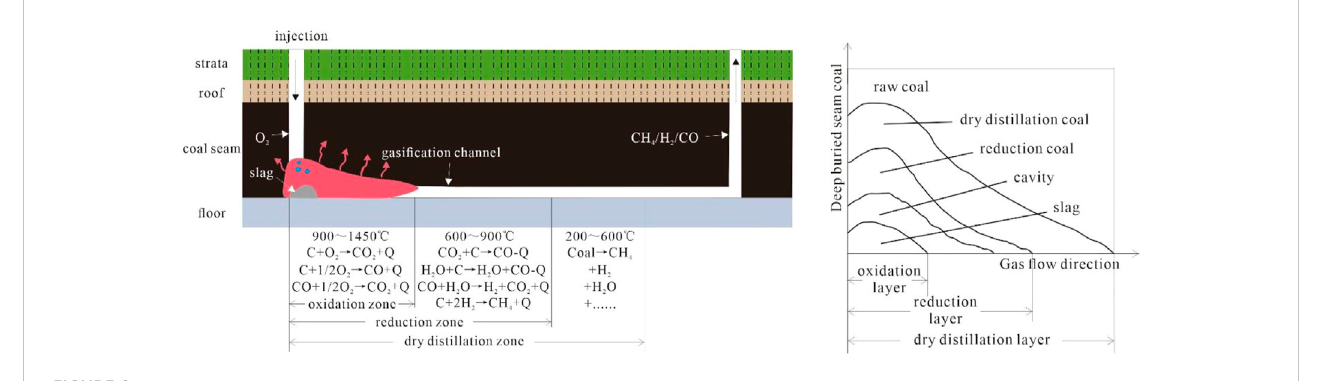
FIGURE 2 Principles of UCG and the gasi fi cation reaction zone diagram.